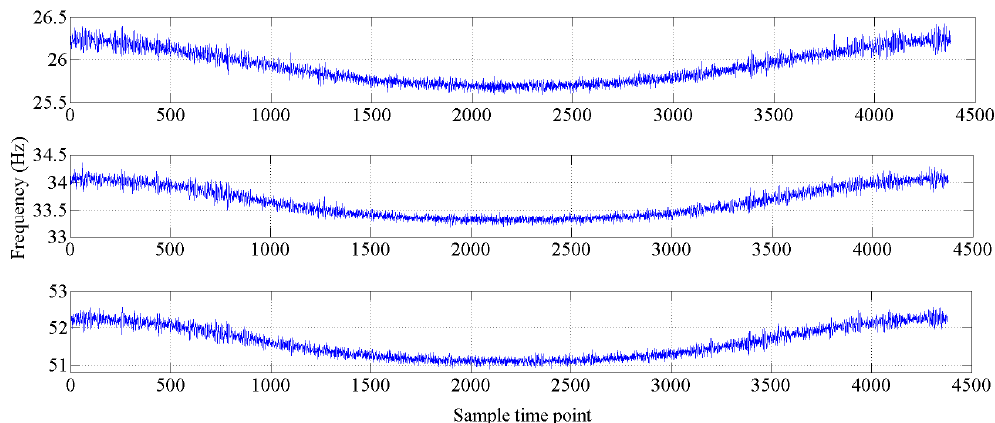
Figure 7. Changes in the natural frequencies (mode 4 to mode 6).